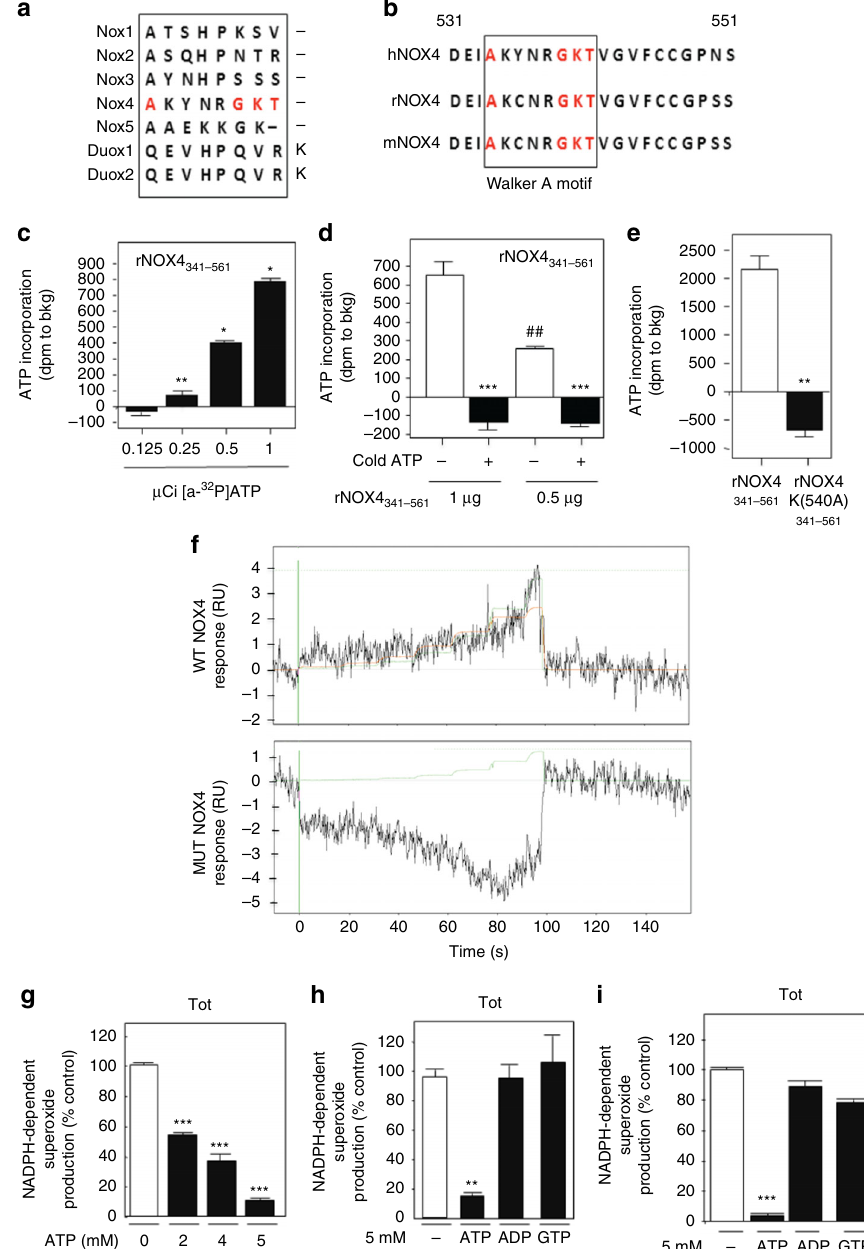
Fig. 1 ATP directly binds NOX4 and negatively regulates NOX4 activity. a Alignment of the human NOX isoforms; NOX1 – 5, DUOX 1, and DUOX 2 shows